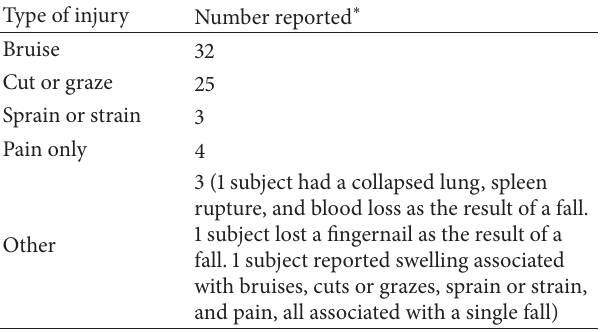
Table 2: Types of injuries reported by the 23 subjects who were injured by a fall in the 6 months